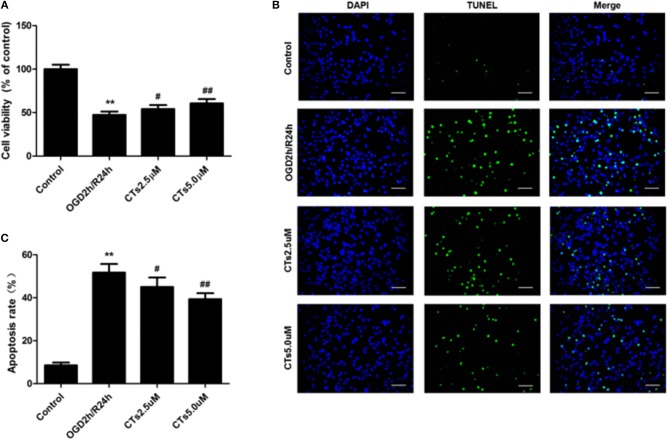
The effects of CTs on cell viability and cellular apoptosis in neurons in OGD/R-injured NVU model in vitro. (A) Cell viability was measured using the CCK-8 assay (n = 4). The cell viability of neurons was calculated by dividing the optical density of samples with the optical density of control. (B) Representative photomicrographs of apoptotic neurons were determined by TUNEL staining. Green fluorescence shows TUNEL-positive nuclei; blue fluorescence shows nuclei of total neurons. Scale bars: 25 μm. (C) The neuronal apoptosis rate was presented as the percentage of TUNEL-positive neurons. The percentage of TUNEL-positive neurons was calculated by dividing the number of TUNEL positive apoptotic neurons with the total number of neurons in 5 high-power fields. Data are presented as the mean ± SD. **P < 0.01 vs. Control group; #P < 0.05, ##P < 0.01 vs. OGD2h/R24h group. CTs, cryptotanshinone.